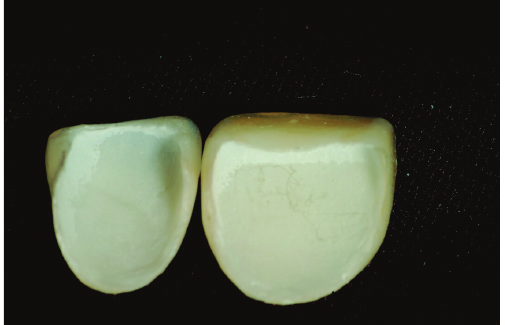
Figure 7: Insertion of gingival retractor cord.